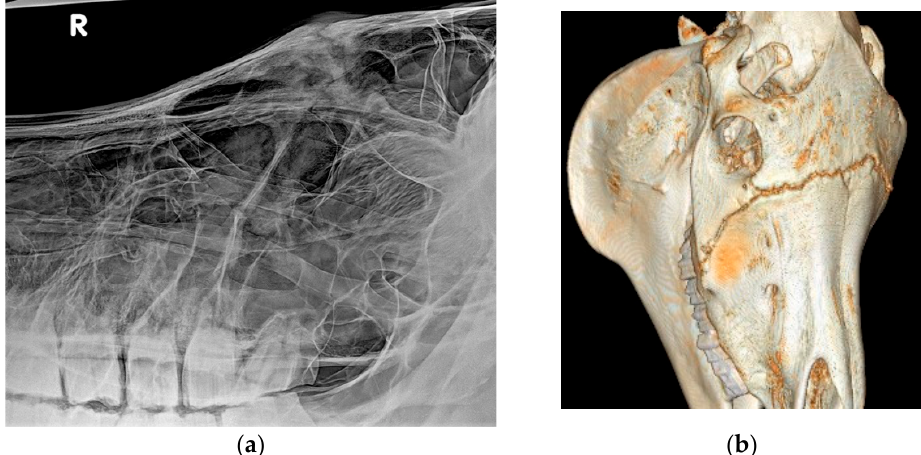
Figure 2. a , b : Xray ( a ) and CT ( b ) reconstruction of a horse with severe suture exostosis secondary to a right sided dental sinusitis. Sinus disease was caused by chronic diastema formation between 108/109 and 109/110 and severe alveolitis. Table 5. Method of surgical access to the sinus in 48 cases of equine suture exostosis developed after sinus surgery.